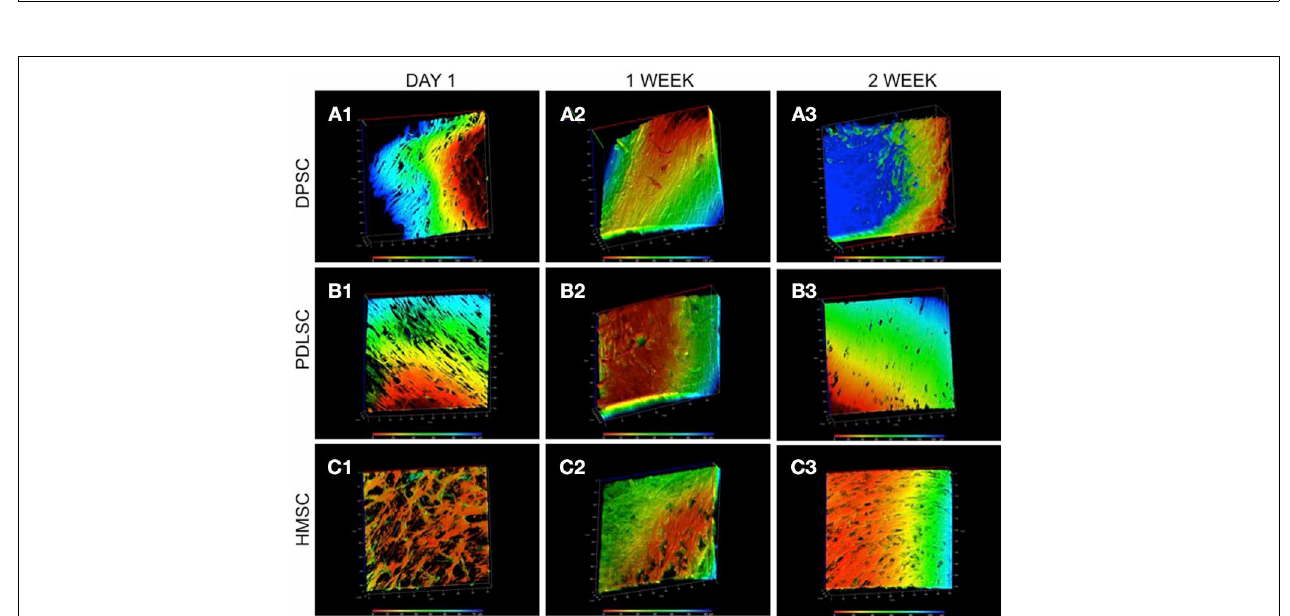
fluorescent cells represent live cells and the red fluorescent cells represent dead cells. All the images were imaged under the same magnification and the scale bar in all the images represents 50 μ m.